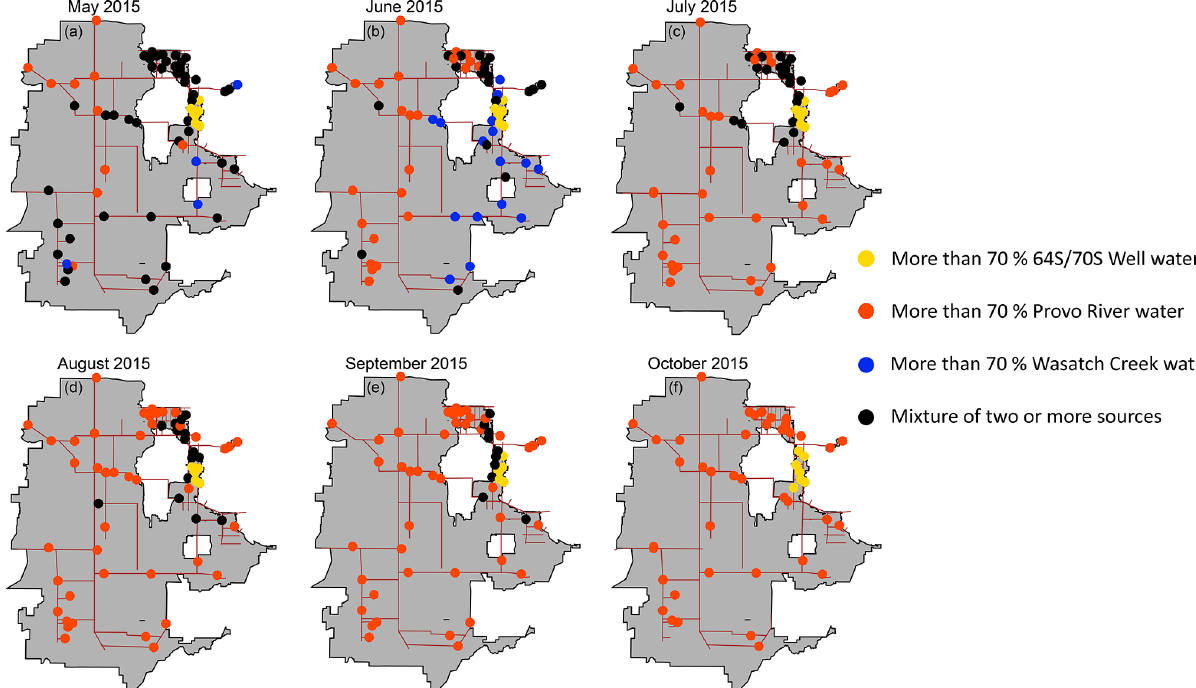
Figure 8. Spatiotemporal variation in sources and distribution sites connectivity from May to October 2015. Distribution sites receiving more than 70% water from a single source are shown in orange, blue, and yellow circles, and sites receiving water from multiple sources (less than 70% water from a single source) are shown in black circle.